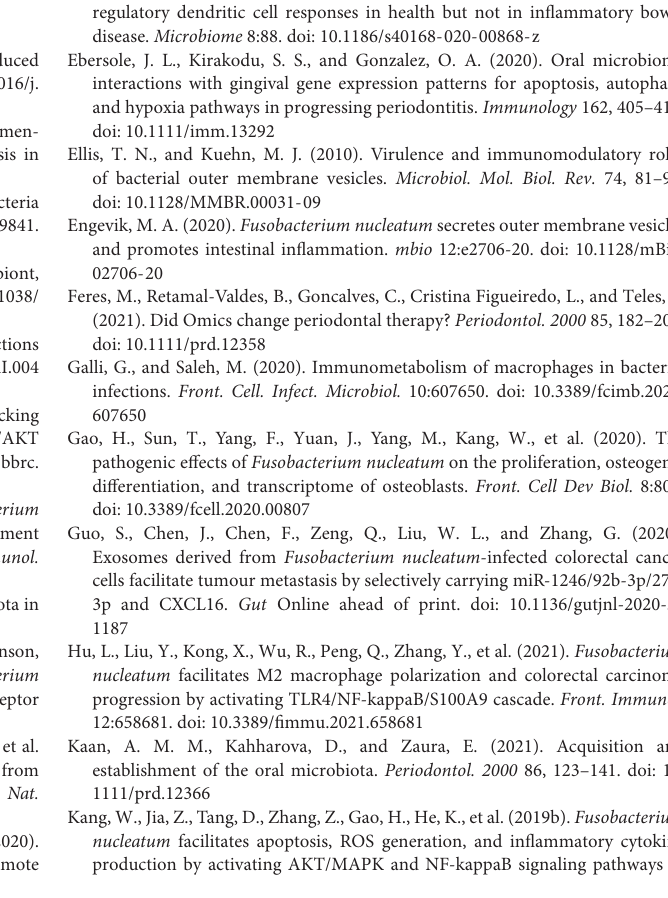
Supplementary Figure 1 | (A) The molecular weight of F. nucleatum OMVs was approximately 40 kD as determined by SDS-PAGE. (B) Mass spectrometry revealed the main component to be a major outer membrane protein that plays roles in (1) immune regulation and (2) and adhesion as well as serves as a (3) channel protein. Supplementary Figure 2 | (A) M1 macrophages marker (CD86) and M2 macrophages markers (Arg-1 and CD163) were detected by western blot after OMVs or IL-4 + IL-13 for 24 h. IL-4/IL-13 were used for positive control. OMVs could not change the protein expression of M2 macrophages markers. (B) The mRNA level of Arg-1 and CD163 was not altered significantly after OMVs or IL-4 + IL-13 stimulation for 24 h. (C) ELISA analysis of M1 marker (TNF- α ) and M2 marker (IL-10) in cultured supernatant of macrophages treated with OMVs or IL-4 + IL-13 for 24 h. (D) Cytokines (IL-1 β , TNF- α , and IL-6) secreted by macrophages gradually increased with time. After stimulation with Fn OMVs for 12 h, macrophages secreted the most inflammatory factors. Supplementary Figure 3 | Immunofluorescence analysis showed the expression of fibroblasts markers FSP1 in